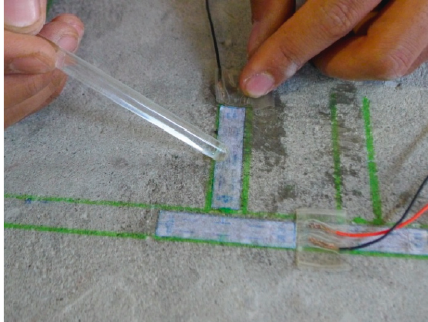
Figure 6: Electrical resistance strain gauge.